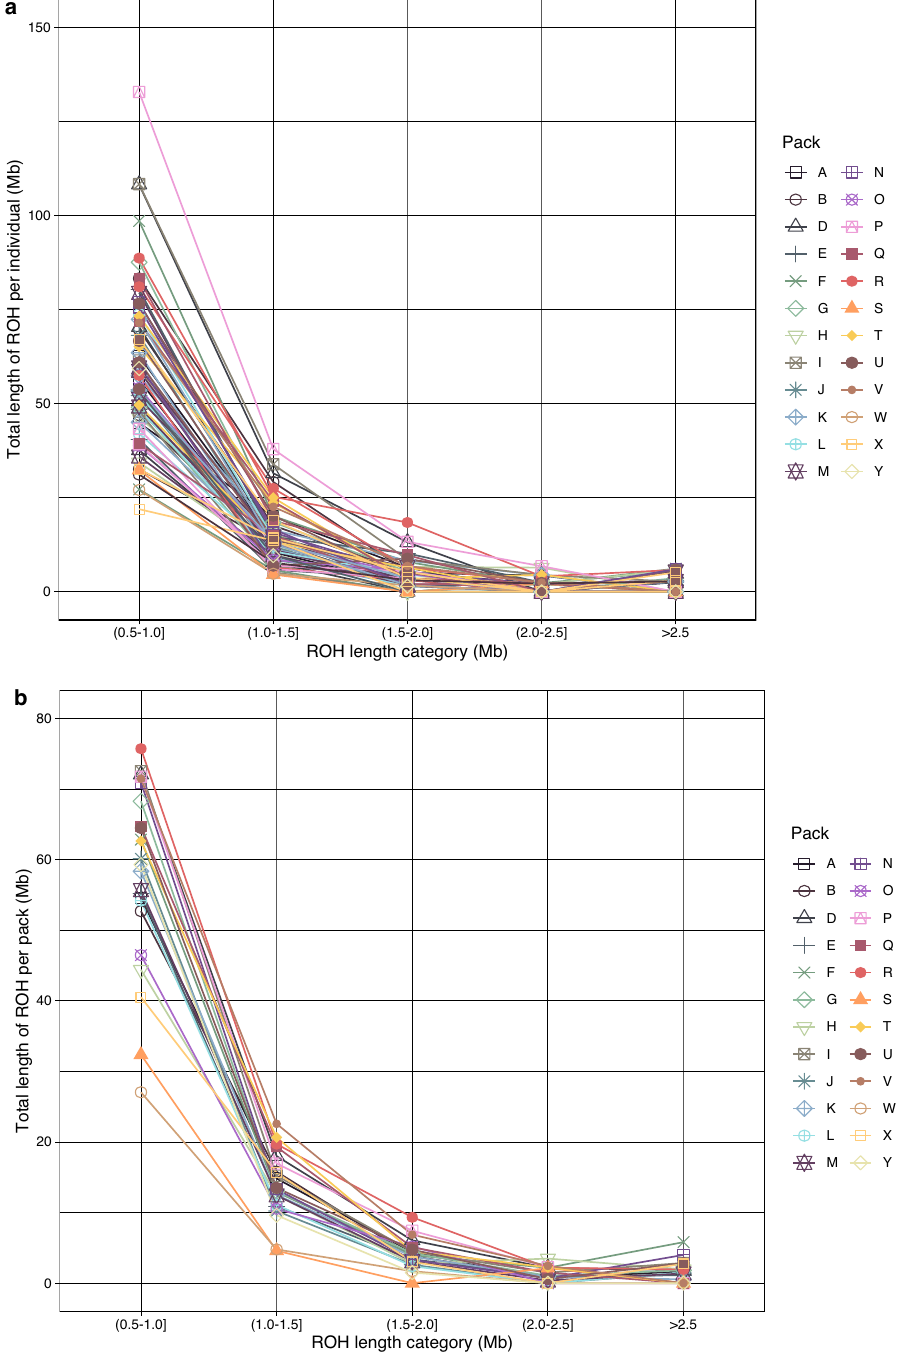
Figure 5. Estimated length distributions of runs of homozygosity (ROH) in 71 African wild dogs ( Lycaon pictus ) from Kruger National Park (KNP), South Africa. ( a ) The total length of ROHs mega base pairs (Mb) over five length categories, described for each African wild dog. Individuals were coloured according to pack. ( b ) The total length of ROHs (Mb) over five length categories of ROH tract lengths as in (a), calculated as the average for each pack. The colouring scheme is the same as in ( a